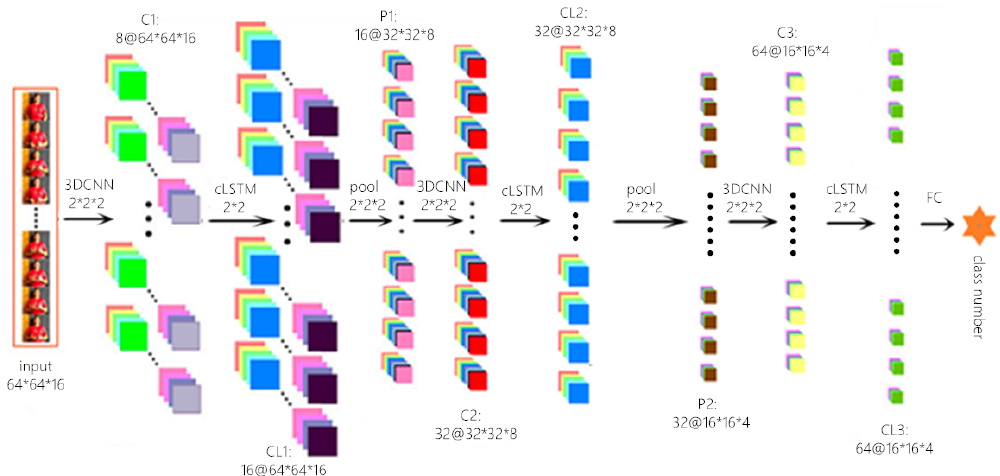
Figure 2. In Figure 2, the MEMP Neural Networks structure as well as the change of the feature graph in each layer of the network structure are shown. The whole process is divided into three parts, video processing, (3D CNN-convLSTM)*3 and FC. Initially, each video is split into 16 consecutive frames. Secondly, these feature sets need to be performed three convolution operations, three convLSTM operations and two pooling operations to obtain more spatial-temporal information. Finally, the network connects the full connection layer to classify these